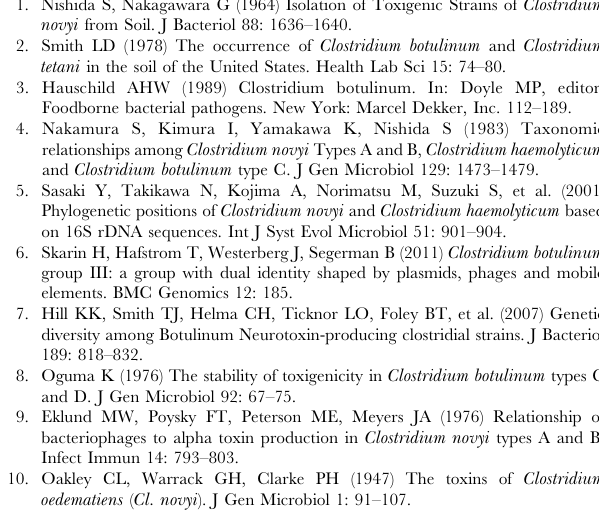
genetic material between plasmids of C. novyi sensu lato. Figure S4 Alignment of the bont gene cluster and surrounding genes in two strains in lineage I. The aligned sequences are from type D strain 16868 and type C/D (subgroup Ia) strain BKT75002 (subgroup Ib). The bont cluster is marked in green and the complete IS element (ISCbo1) identified in strain 16868 is marked in red. Table S1 Sequencing data and assembly quality statis- tics. Table S2 Predicted presence and copy-number of IS elements in the strains. Table S3 Genomic properties of the plasmids identified in C. novyi sensu lato . Table S4 The result of the plasmid curation experi- ment. Table S5 Plasmid replication and maintenance